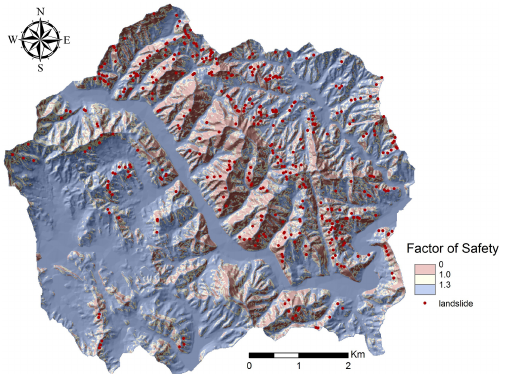
Figure 13. Map showing the factor of safety predicted using the proposed model.